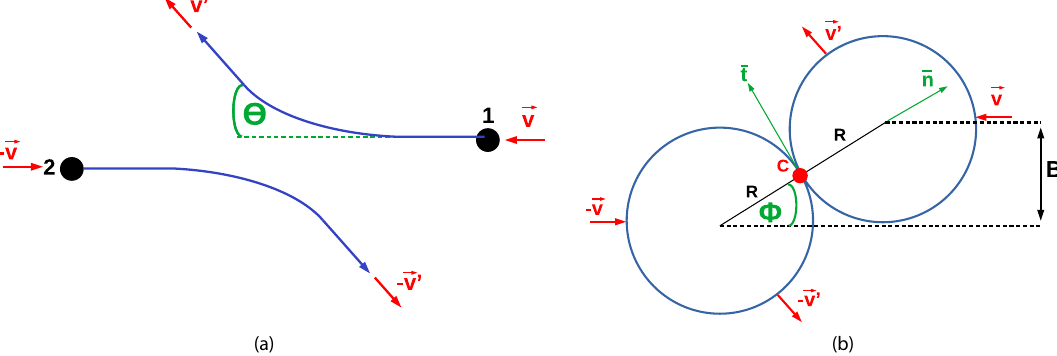
Figure 1. ( a ) Sketch of the collision of NP1 and NP2 in the center-of-mass frame. The initial collision velocity of NP1 is v , its post-collision velocity is v ′ ; they make an angle θ . Because of symmetry, NP2 has – apart from the sign – the same pre- and post-collision velocities and deflection angle as NP1. ( b ) Sketch of the collision kinematics at the moment where the two NPs touch at point C. C is also the – unmoving – center of mass of the system. The blue circles denote the NPs, R is the NP radius, B the impact parameter, and the angle φ is given by Eq.